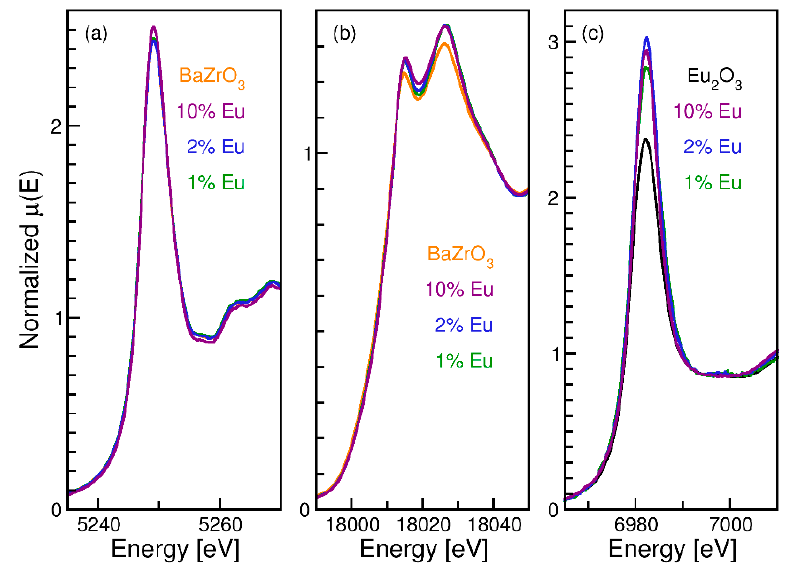
Figure 2. Normalized XANES spectra of the BZOE samples and standards at the ( a ) Ba L 3 -edge, ( b ) Zr K-edge, and ( c ) Eu L 3 -edge. ( b ) Zr K-edge, and ( c ) Eu L 3